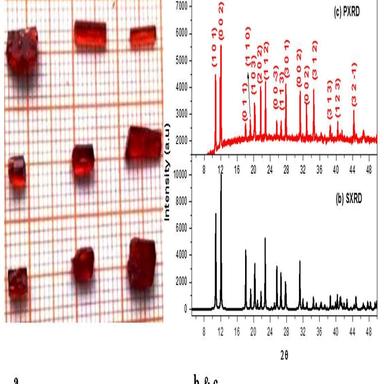
(a) Photograph of grown single crystals-PCOH, (b) Single crystal XRD (SXRD) pattern refinement data of PCOH and (c) The indexed powder X-ray diffraction (PXRD) pattern of PCOH.